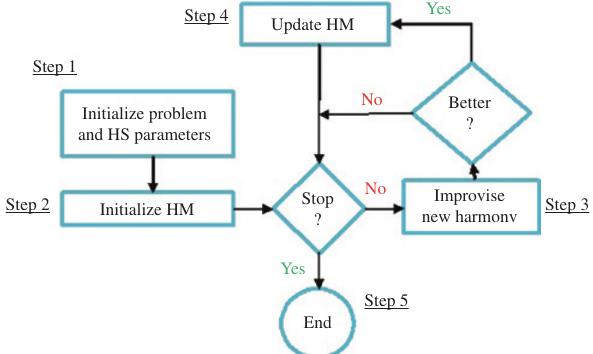
Figure 1: The Flowchart of HS